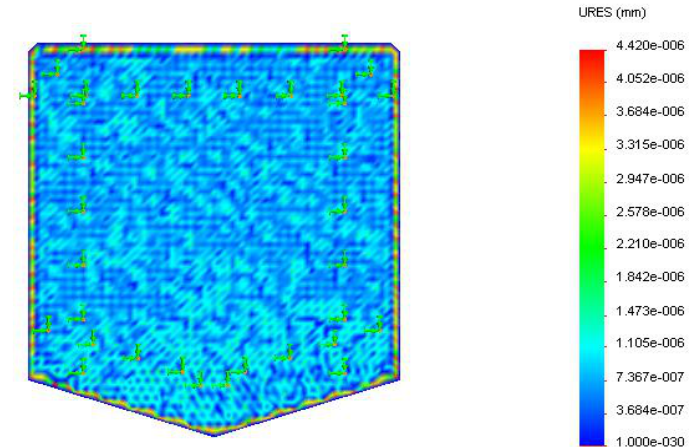
Figure 11. Displacement (in mm) of the polyester substrate at 323 K.